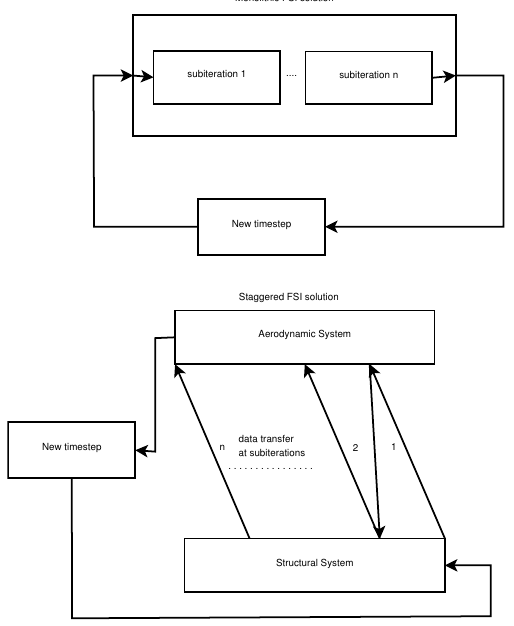
Figure 1. Coupling approaches in